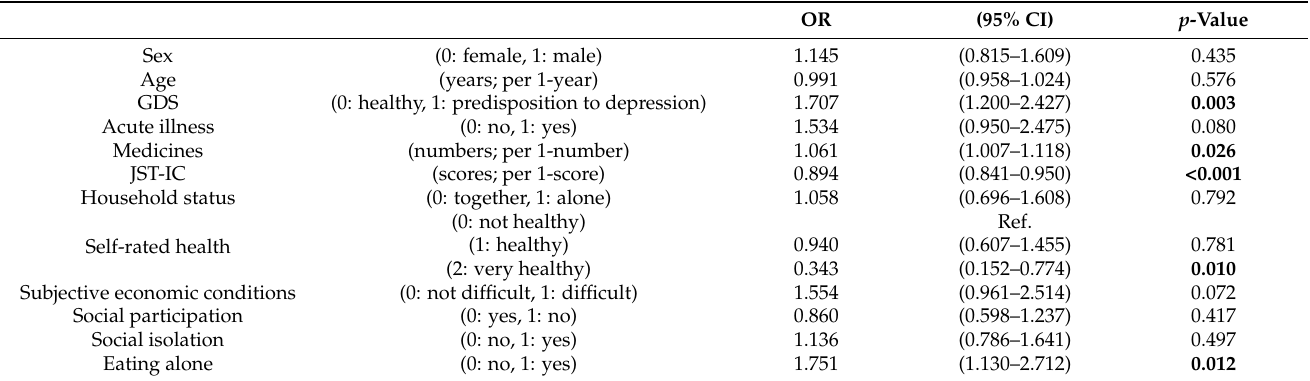
Table 2. Odds ratios and 95% confidence intervals for eating alone according to appetite